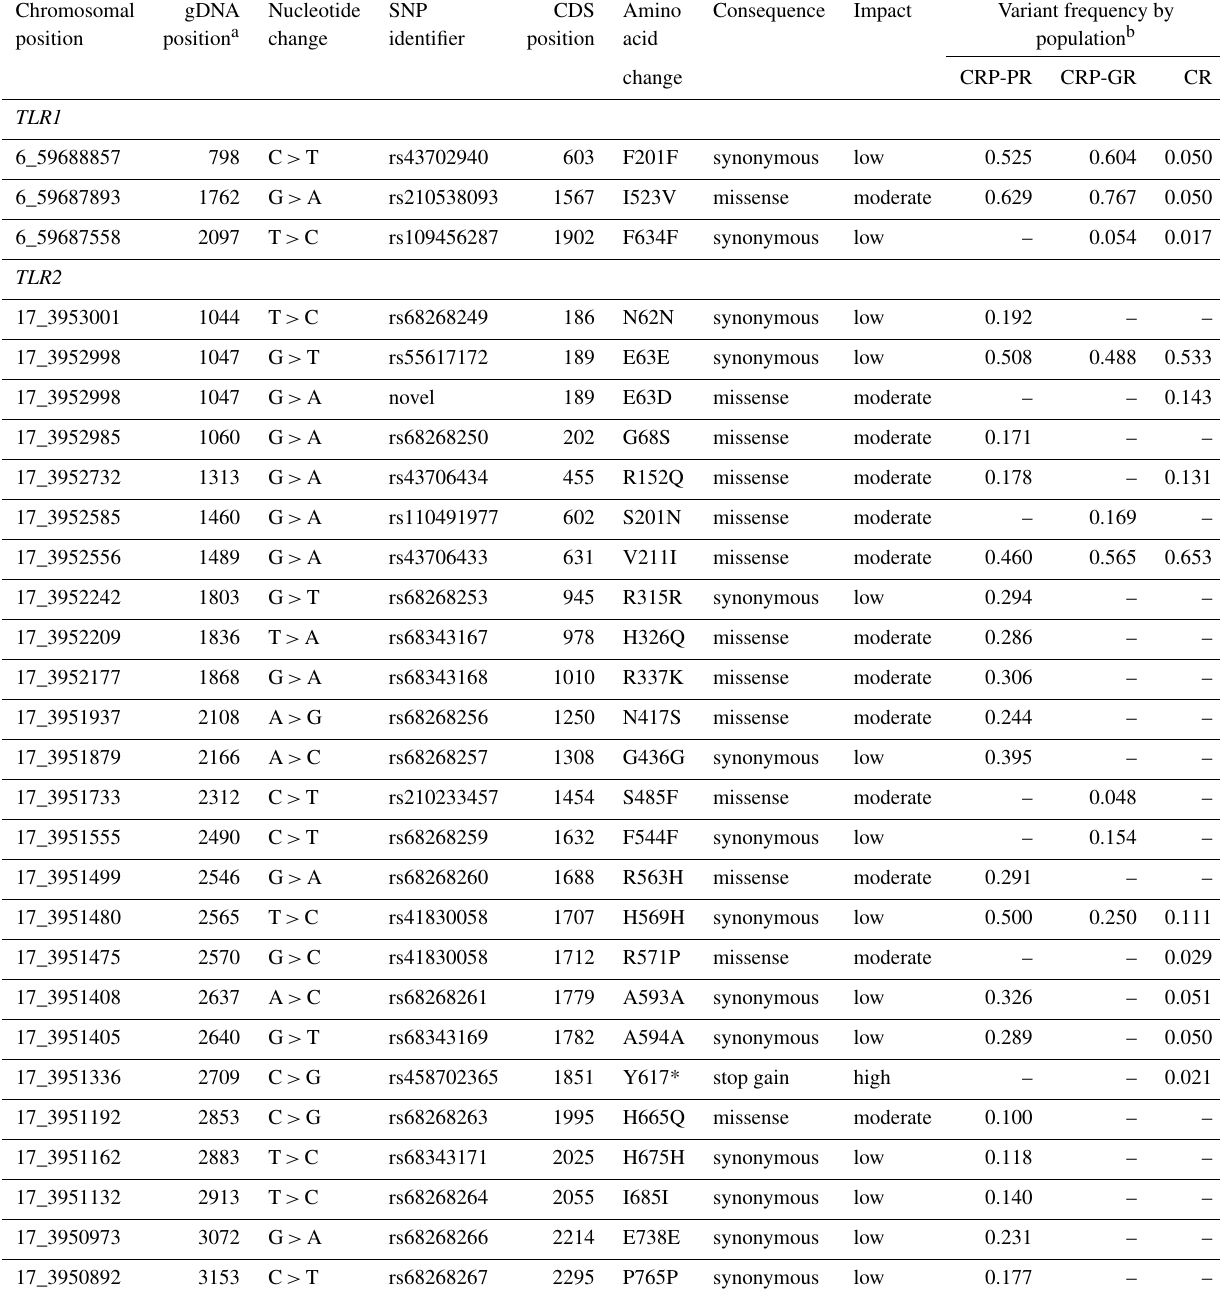
Table 3. SNPs located to the coding sequence or to the promoter region of antibacterial TLR s present in the populations of Czech Red Pied and Czech Red cattle.